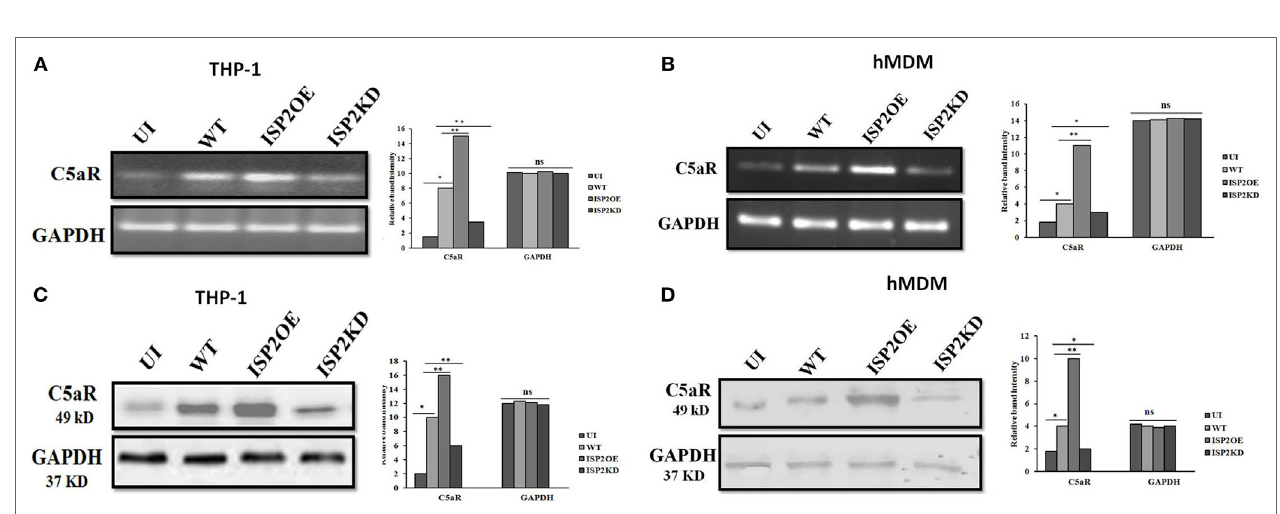
FigUre 8 | Effect of Leishmania donovani inhibitor of serine peptidases 2 on C5aR expression in infected macrophages. THP1 monocyte-derived macrophages (a,c) and human monocyte-derived macrophages (hMDM) (B,D) were either left UI or infected with WT, ISP2OE and ISP2KD Leishmania parasites for 12 h. The expression level of C5aR was analysed at transcript level by semi-quantitative PCR (a,B) and at protein level by western blot (c,D) . Densitometric analysis showed the relative fold increase in the band intensities of C5aR expressed in the different group of infected parasites when compared to the UI or WT infected macrophages. Experiments were performed in triplicate. Gel and blot images are representative of a single experiment. An asterisk (*) denotes P ≤ 0.05 and the double asterisk (**) denotes P ≤ 0.001, when compared to UI or WT infected as applicable, “ns” denotes non-significant changes (Mann–Whitney U test). Abbreviations: UI, uninfected; WT, wild-type; ISP2OE, ISP2 overexpressed; ISP2KD, ISP2 knocked